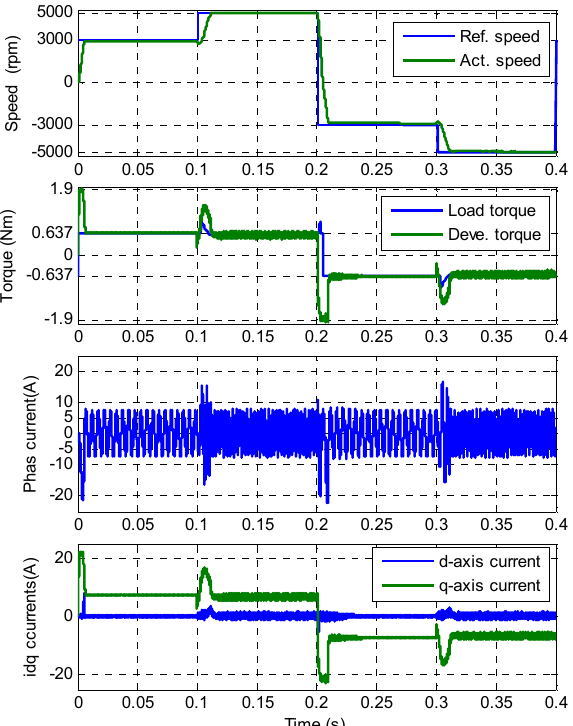
Figure 5. The dynamic performance of the PMSM side with modulated FCS-MPC. From top to bottom: reference and motor speeds, load and developed torques, phase current, and dq currents.